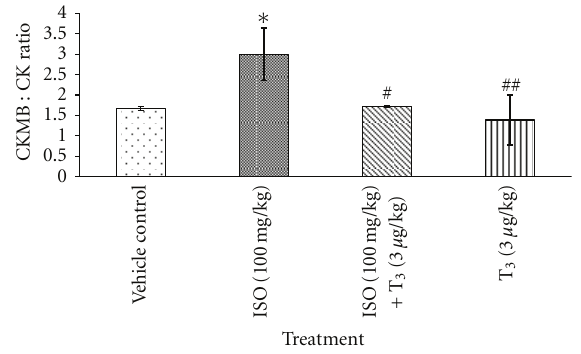
Figure 3: E ff ect of T 3 on CKMB: CK Ratio, values are presented as Mean ± SD, n = 5, ∗ : significant from control group at 0.05% level ( P < 0 . 05), # : significant from ISO control group at 0.05% level ( P < 0 . 05), ## : significant from ISO control at 1% level ( P < 0 . 01), SD: Standard Deviation.